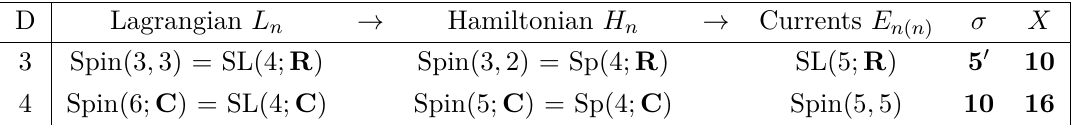
Table 3 . Symmetry groups of fundamental F-theory branes. The symmetry manifested by the Lagrangian and Hamiltonian formulations of the fundamental branes of F-theory corresponding to type II strings in D = 3 and 4 dimensions. The rank of the global exceptional symmetry n = D + 1 and the E representations of the worldsheet ( σ ) and target ( X ) coordinates are given in the n ( n ) last two